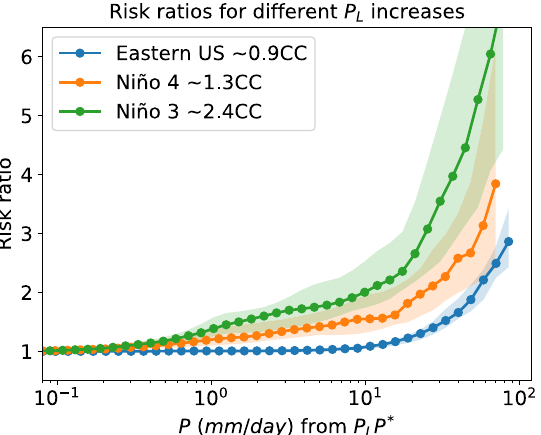
Figure 6. Risk ratio (2075–2099 vs. 1990–2014) in three regions with different P L increases: the Eastern United States (25 ◦ N-48 ◦ N,66 ◦ W-103 ◦ W), the Niño 4 region (5 ◦ S-5 ◦ N,160 ◦ E-150 ◦ W), and Niño 3 region (5 ◦ S-5 ◦ N,150 ◦ W-90 ◦ W). Solid lines show the multi-model mean and shading denotes the 25–75th percentiles spread across models. Risk ratios are calculated in scaled coordinates in each model prior to calculating the multi-model mean, and then scaled back by the multi-model mean increase in P L . In the Eastern US, the multi-model mean = 15.1 mm in the historical case (1990–2014) to P fut = 18.1 mm at the end of the century P L increases from P his L L (2075–2099) for an increase of approximately 6% per global mean temperature increase (multi-model mean of 3.96 ◦ C ) (approx. 0.9 × CC ). Changes in τ P are more modest, with multi-model mean of τ his P = 0.64 and = 0.68 . In the Niño 4 parameters in each period are τ his = 0.63 , τ fut = 0.6 , P his = 14.8 mm, P fut = 20.3 mm τ fut P P L P L fut = 0.75 , P his = 12.7 mm, P fut = 21.1 mm (increase of approx. 1.3 × CC ). In the Niño 3 region: τ his P = 0.77 , τ P L L (increase of approx. 2.4 × CC